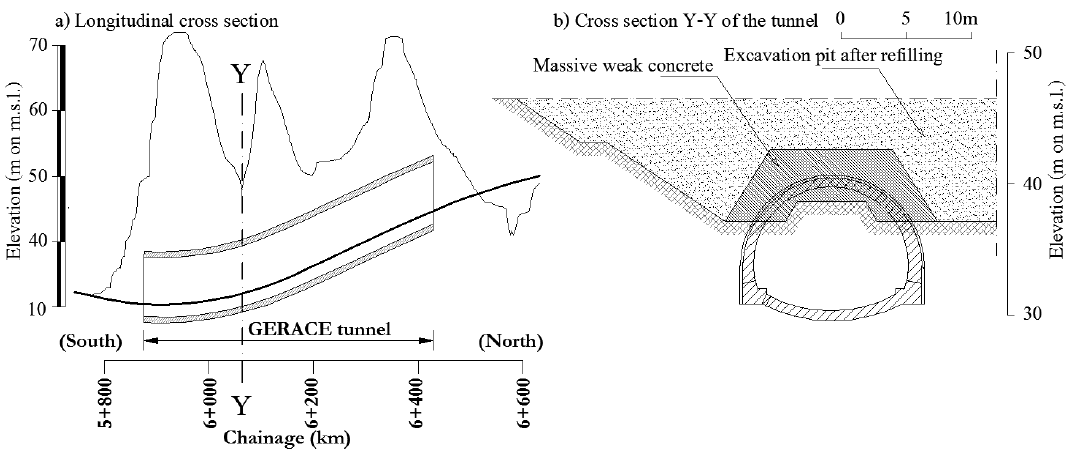
Figure 11. ( a ) Longitudinal cross-section of the Gerace tunnel; ( b ) Cross-section Y-Y of the